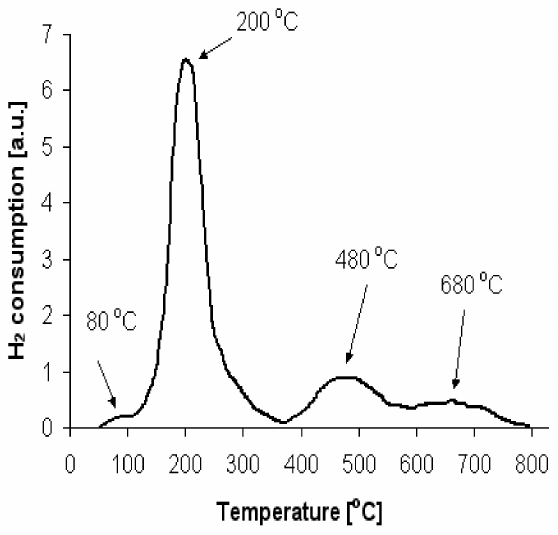
Figure 2. TPR profile of the Pt/Al 2 O 3 catalyst sample.